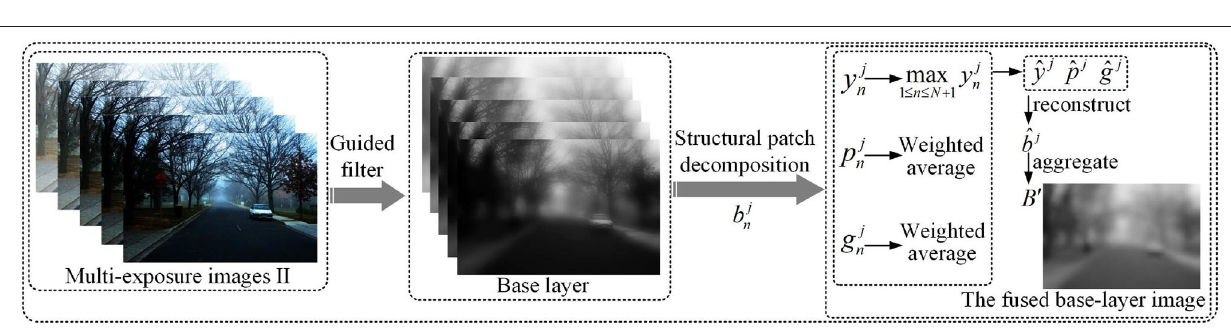
FIGURE 4 | The fusion process of the base layer. b j n represents image patches. y j n , p j n , and g j n represent signal strength, signal structure, and mean intensity, respectively. y j , p j , and g j represent the desired signal strength, signal structure, and mean intensity, respectively. ˆ b j represents the fusion of image patches, B ′ is the fused base-layer